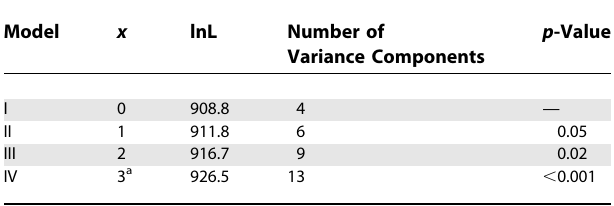
Table 2. Comparison of Random-Regression Animal Models